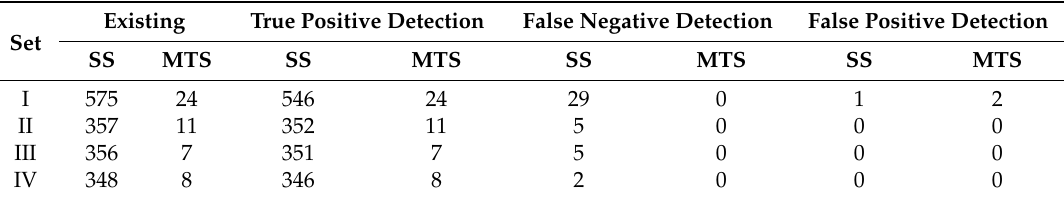
Table 6. Detection and positioning of support structure results. Support structures single solution, SS; multi-track solution, MTS.